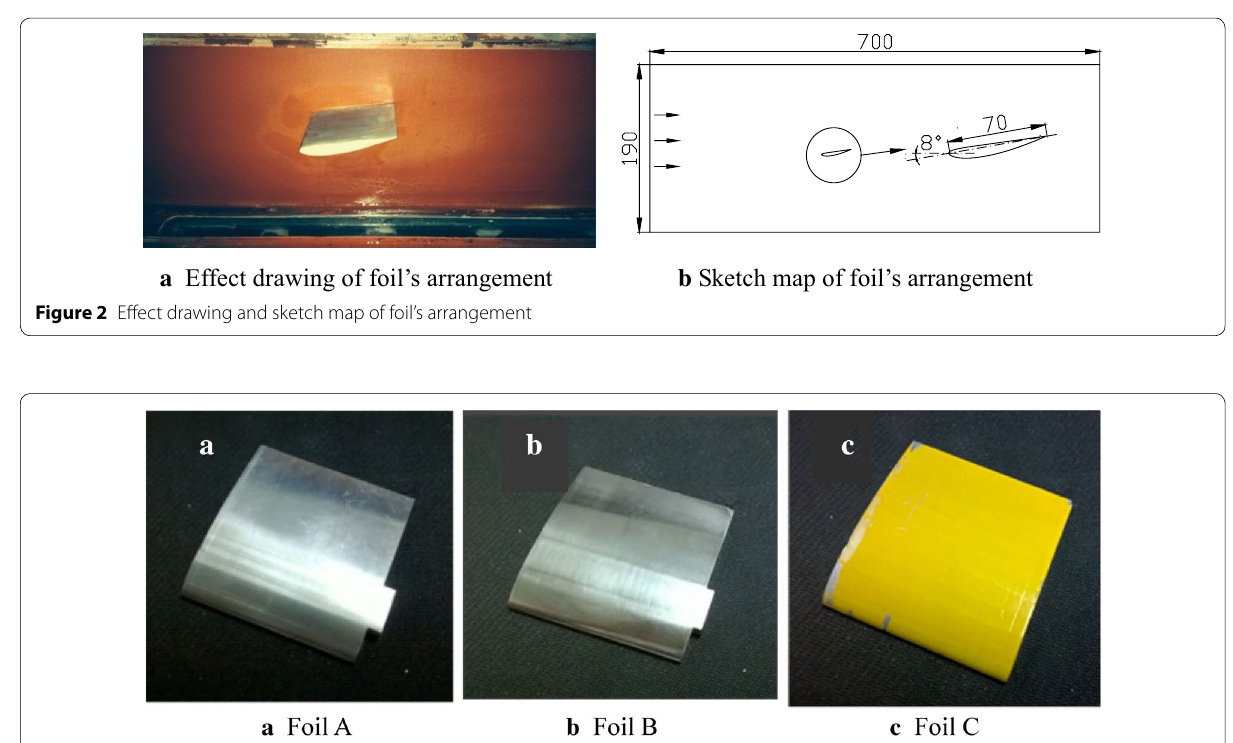
Figure 3 Photos of hydrofoils made of different